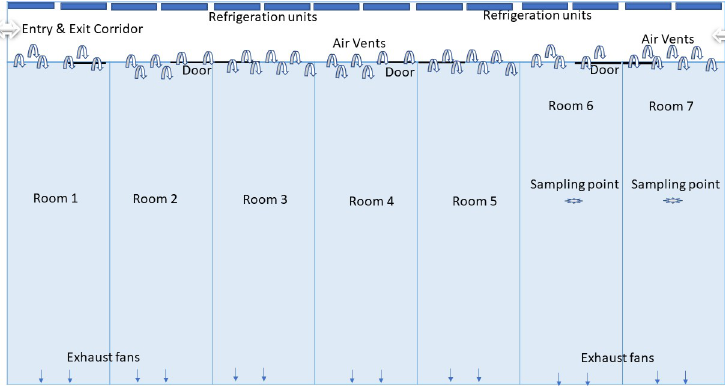
Fig 1. Scheme of the weaning shed with seven weaning rooms and locations of exhaust fans, air vents, refrigeration units and sampling points.